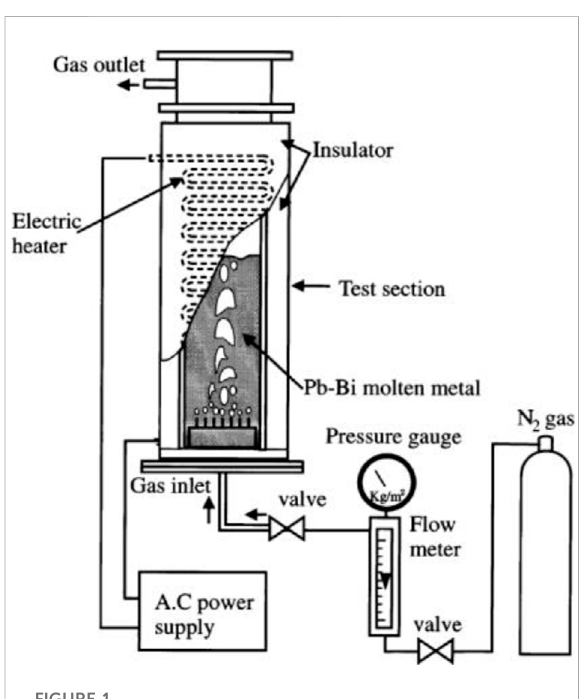
FIGURE 1 Diagram of the JNC & KyotoU test facility (Hibiki et al., 2000).